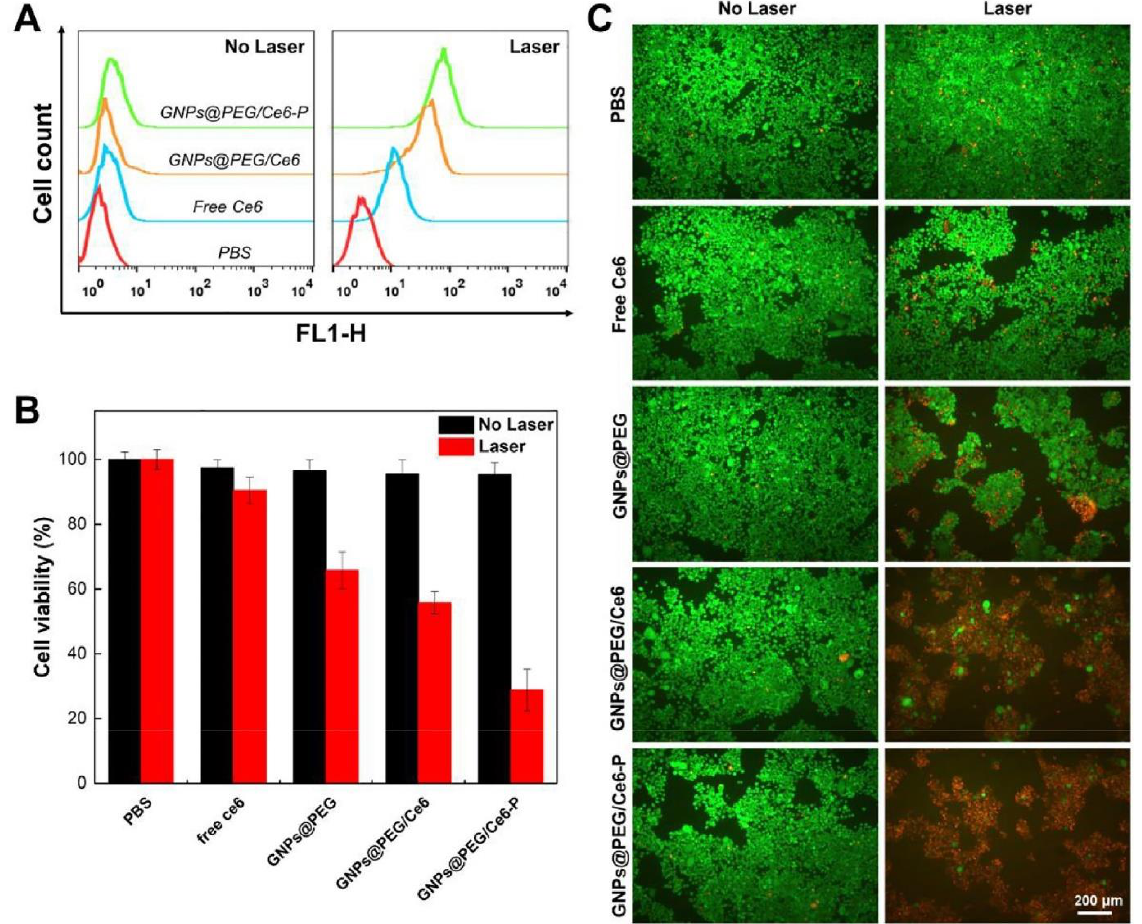
Figure 11. Impact of PBS, free Ce6, nontargeted NP, and targeted NP on HCC872 cell viability. ( A ) ROS generation of HCC827 cells after treatment with PBS, free Ce6, nontargeted NP, and targeted NP for 12 h in the absence and presence of laser irradiation. ( B ) Different NP effects on the viability of HCC827 cells, with and without laser irradiation. ( C ) Dead/live assay on HCC827 cells with different NPs before and after laser irradiation (green dots and red dots suggest live and dead cells, respectively). Reproduced with permission from Ref.